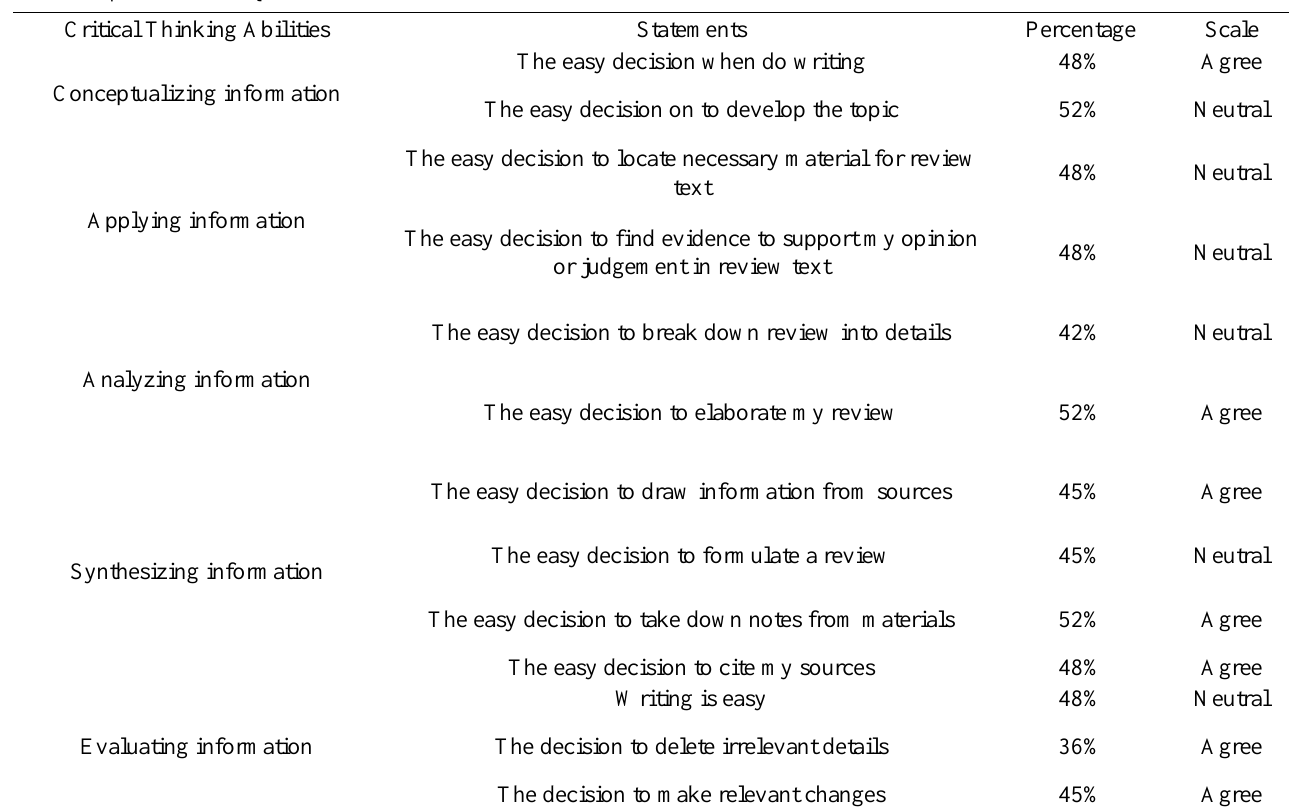
TABLE 6 | Resume of the Questionnaire Results Critical Thinking Abilities Conceptualizing